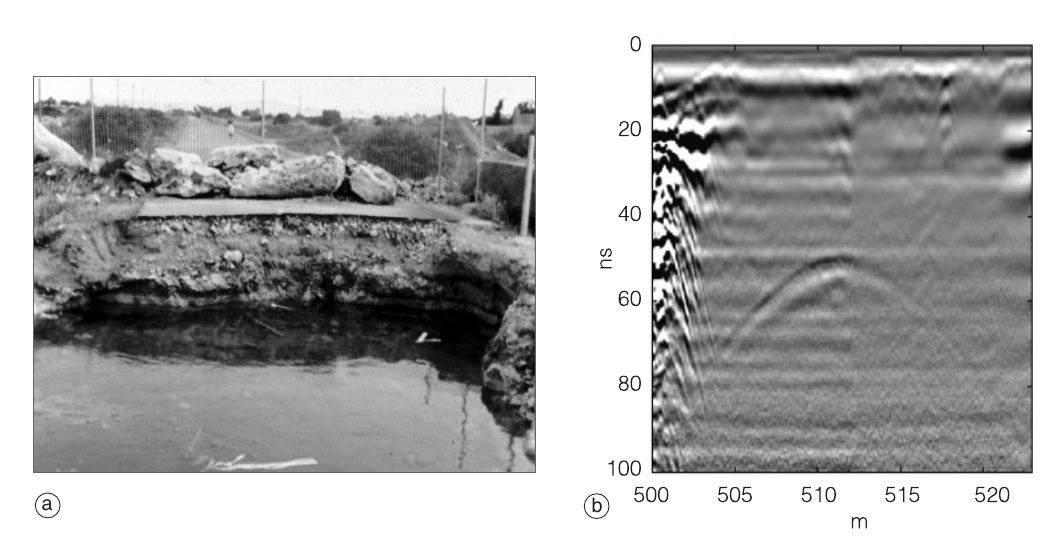
Fig. 5a,b. Example 3: S. Isidoro-Torre Inserraglio street (Lecce, Italy) – Surface-scattering from a cable. a) Water- filled karstic cavity collapsed in 1992. b) Radar section showing a diffraction hyperbola from an aerial telephone cable crossing the street near the debris-refilled collapse